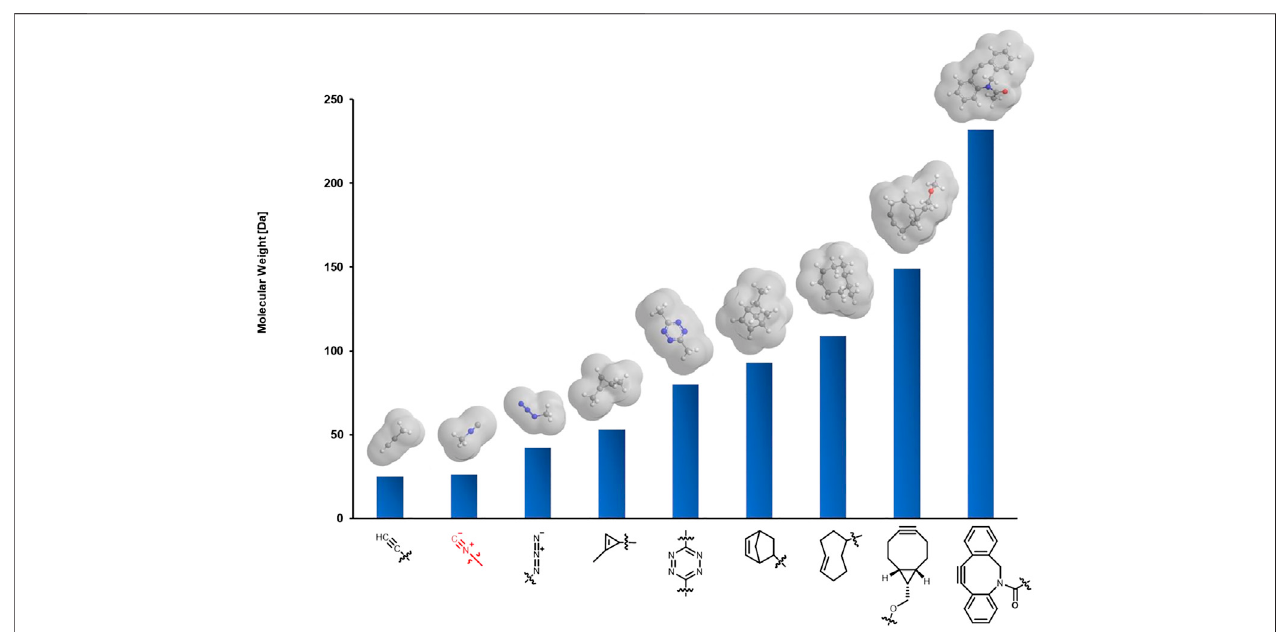
FIGURE1| Comparisonofthesizeofisocyanogroupwithothercommonlyusedbioorthogonalfunctionalities.Moleculesareshownwiththecorrespondingmethyl derivatives.